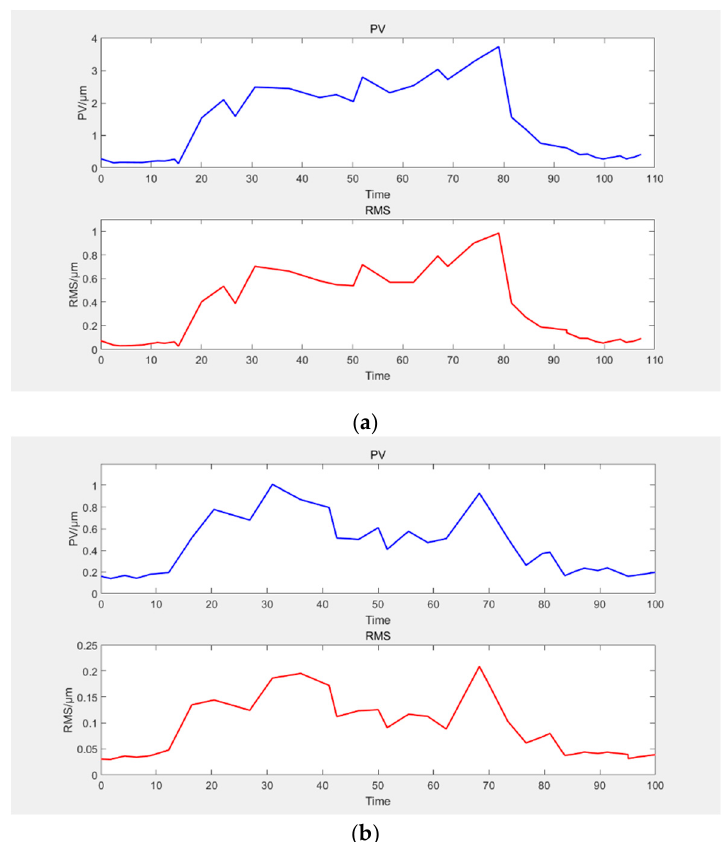
Figure 11. Wavefront aberration profiles over time: ( a ) wavefront aberration with tilt; ( b ) wavefront aberration without tilt.